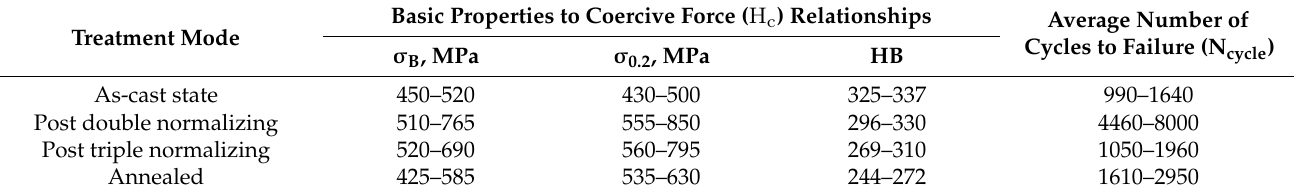
Table 4. Assessment of the hypereutectoid steel main mechanical properties by H c